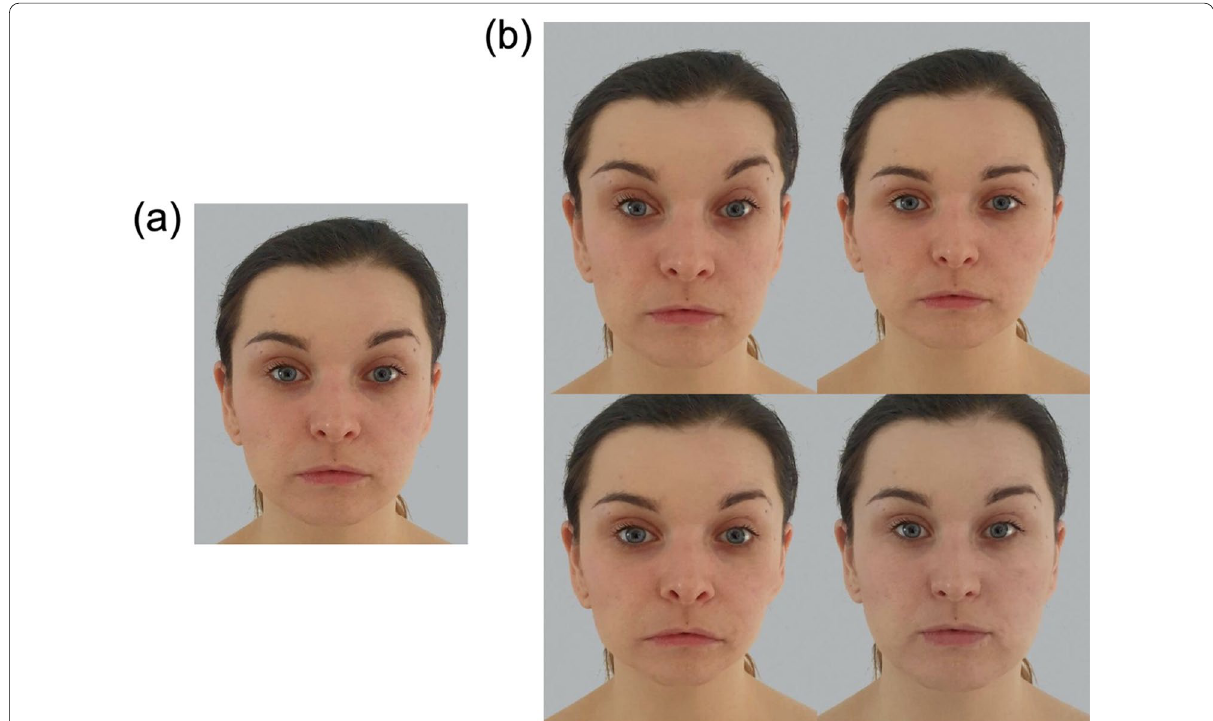
Fig. 1 An example identity, morphed to appear more or less average in appearance. a The original, unaltered image. b Image sequences featured shape changes to only the upper (top row) or lower half of the face (bottom row). Images depict the original image and average were located at 0% and 100%, respectively. This woman did not appear in the experiment itself, and has given permission for her image and morphs to be reproduced